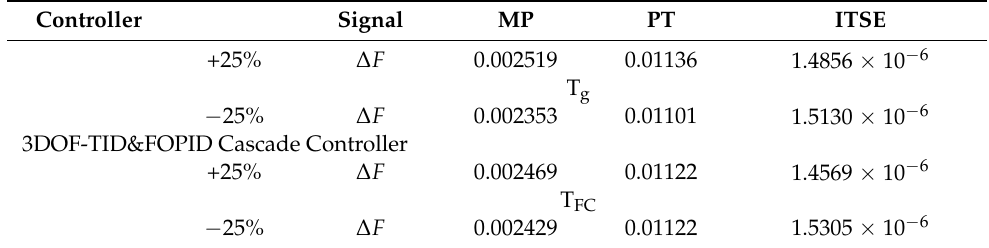
Table 3. Sensitivity analysis for the proposed controller under ± 25% variations in T DEG and T FC .